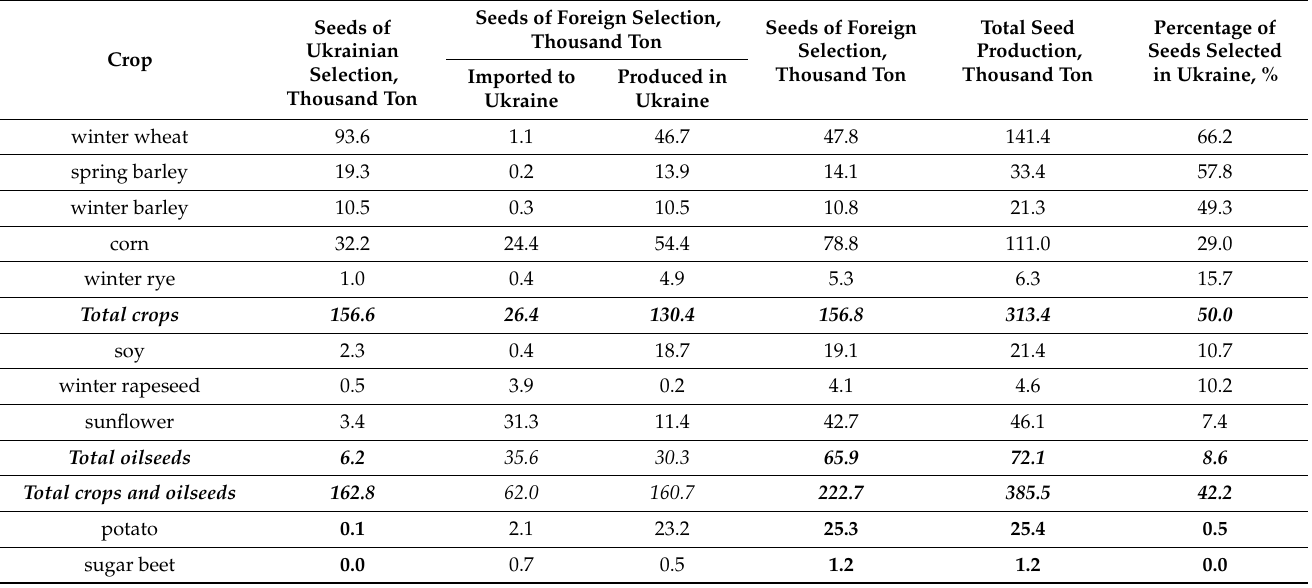
Table 4. Production of certified seeds of the main crops in Ukraine in 2020 (prebase, base, and